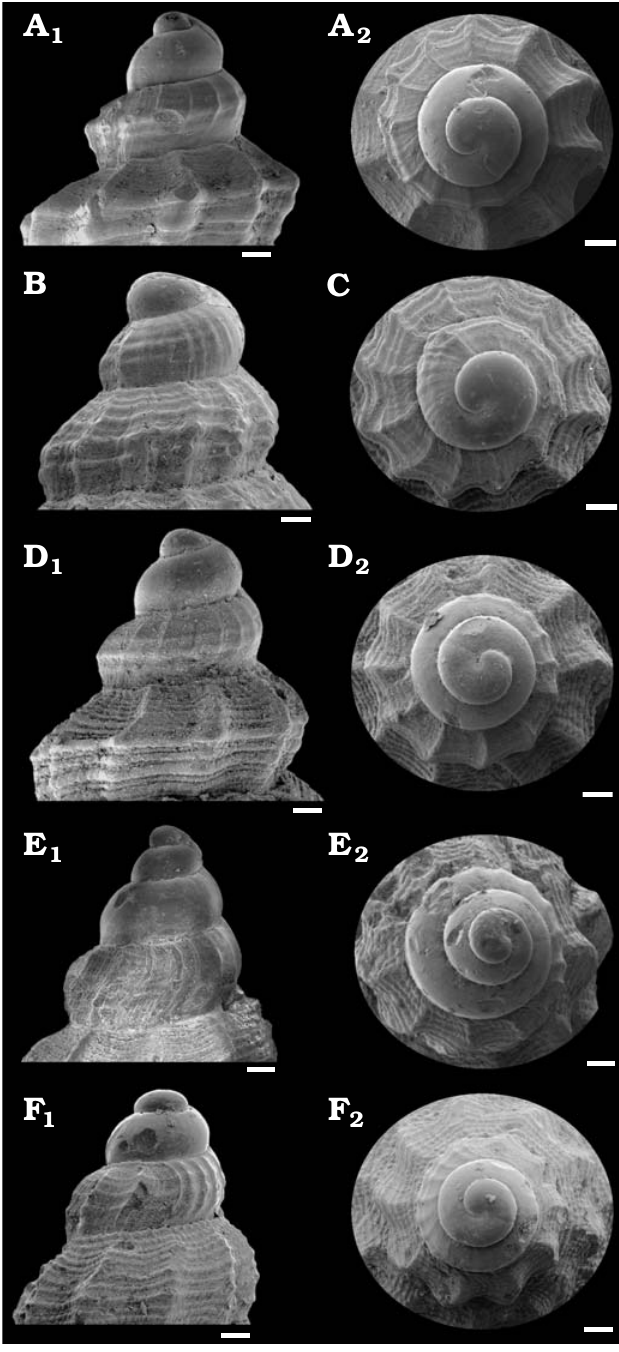
Fig. 4. SEM images of protoconch features of new conoidean gastro- pods from early Serravallian of western Ukraine, Varovtsi (A–C, F) and Velyka Levada (E). A . Mangelia angulicosta sp. nov., MGGC 24506/6. B . Mangelia larga sp. nov., MGGC-24508/1. C . Mangelia larga sp. nov., MGGC-24508/7. D . Mangelia pseudorugulosa sp. nov., MGGC-24510/9. E . Mangelia odovychenae sp. nov., MGGC-24512/1. F . Bela varovtsiana sp. nov., MGGC-24517/5. Views: A 1 , B, D 1 − F 1 , lateral; A 2 , C, D 2 − F 2 , api- cal. Scale bars 0.1